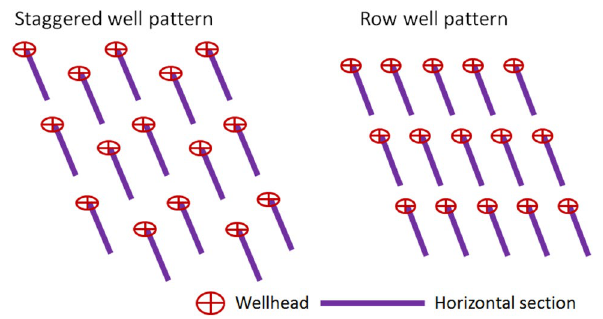
Fig. 7 Sketch map of row well pattern and staggered well pattern